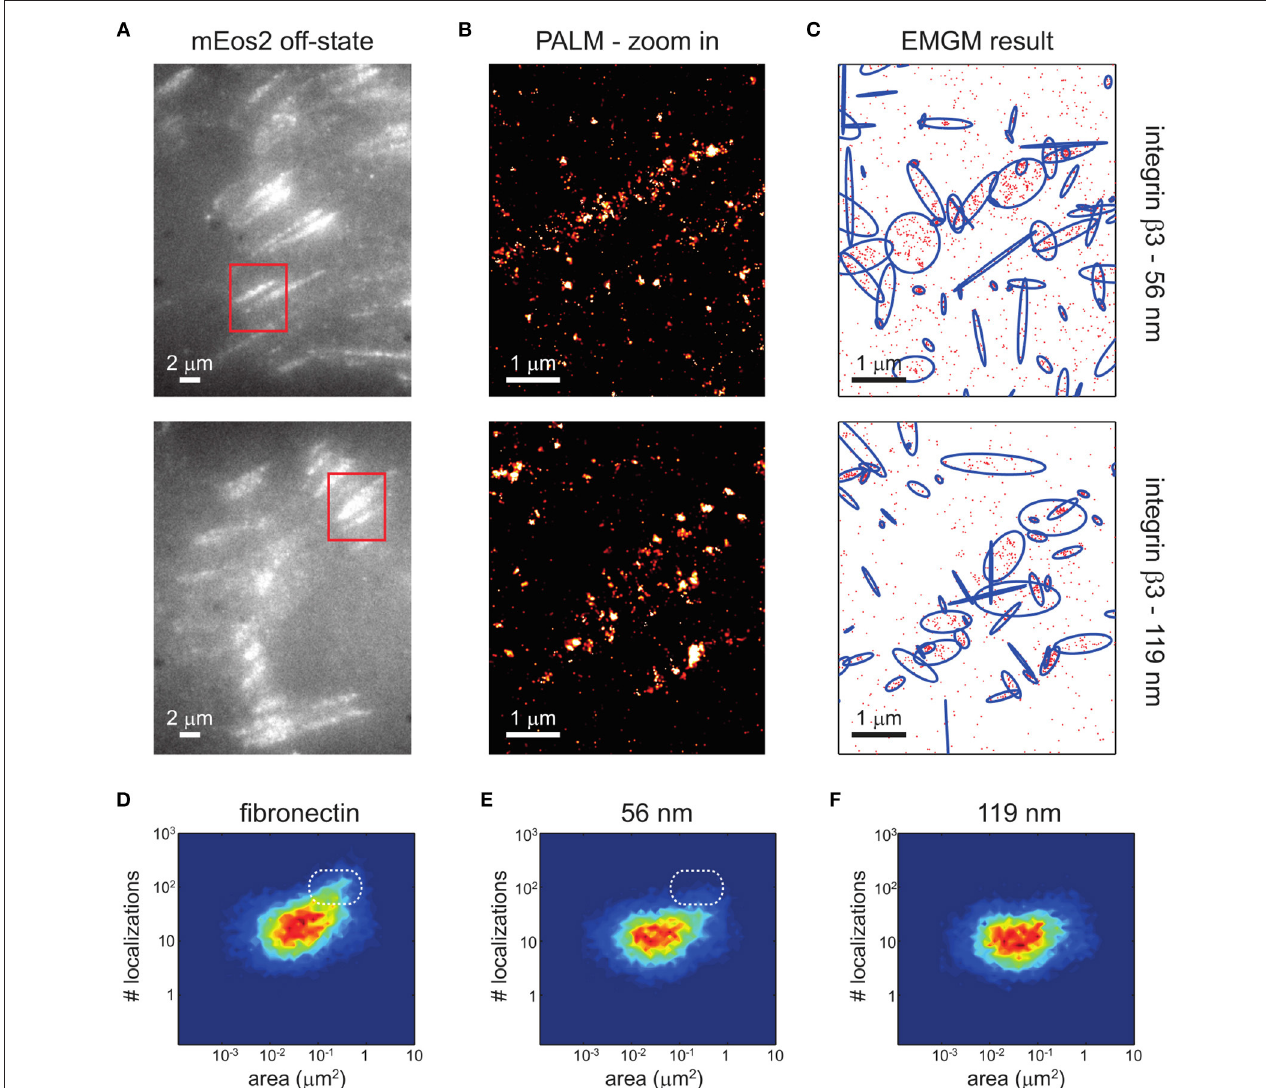
FIGURE 5 | EMGM analysis of PALM data of integrin β 3 on nanopatterned substrates. (A) Shown here are summed TIRF images of the mEos2 off-state of fixed REF cells expressing integrin β 3 labeled with mEos2, growing on nanopatterned substrates with 56- or 119-nm spacing between the AuNPs. (B) Shown here are zoom-in PALM images corresponding to the red rectangles in (A) . (C) Given here is the result of the EMGM analysis of the PALM data shown in (B) . The red dots symbolize the localizations,and the blue ellipses symbolize the 2 σ error ellipses of the mixture components. (D–F) Given here is the result of the EMGM analysis of PALM data corresponding to different REF cells ( n = 10). The number of localizations in each mixture component is shown as a function of the area of its 2 σ error ellipse, for (D) fibronectin-coated substrates, (E) nanopatterned substrates with 56-nm spacing, and (F) nanopatterned substrates with 119-nm spacing. The dashed white rounded rectangles in (D,E) are visual guides. [Figure and figure caption reproduced from (Deschout et al., 2017), figure reference omitted]. Reprinted from Biophysical Journal, 113, Hendrik Deschout, Ilia Platzman, Daniel Sage, Lely Feletti, Joachim P. Spatz, Aleksandra Radenovic, Investigating Focal Adhesion Substructures by Localization Microscopy, 2508-2518, Copyright (2017), with permission from